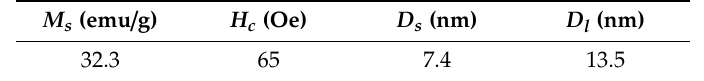
Table 1. Magnetic parameters and range of particle diameters for the ZnFe 2 O 4 sample.